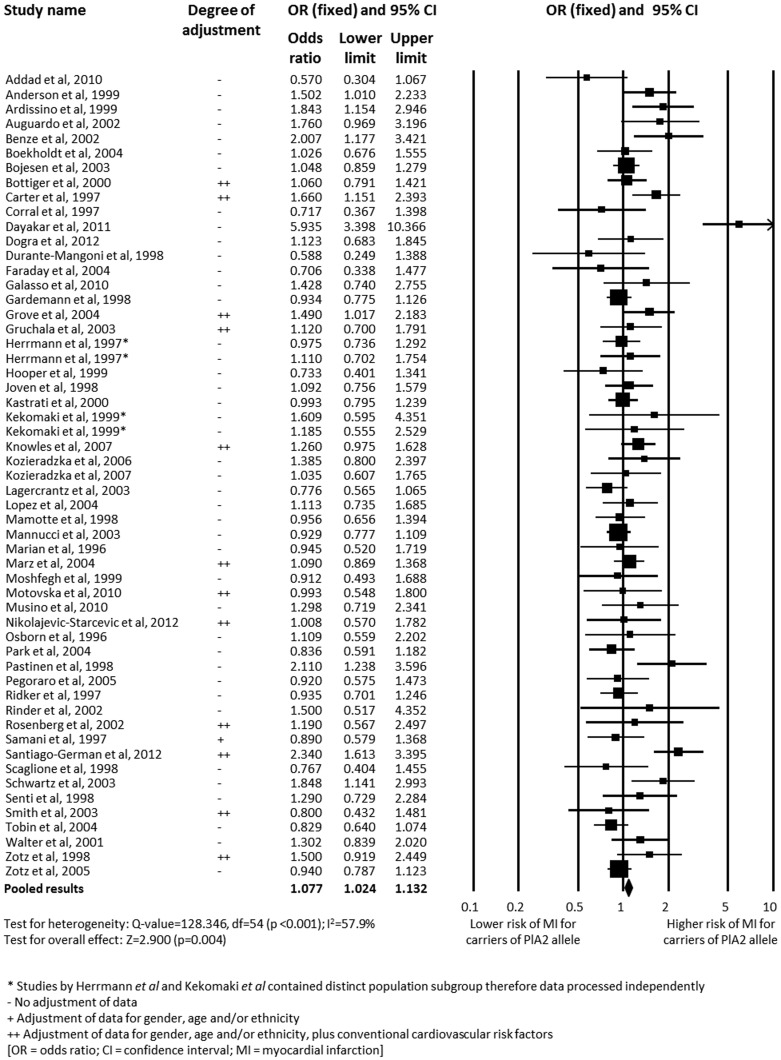
Analysis of the association between carriage of the PlA2 allele and myocardial infarction.Analysis is of the PlA1/A1 versus PlA1/A2+PlA2/A2 genotype.